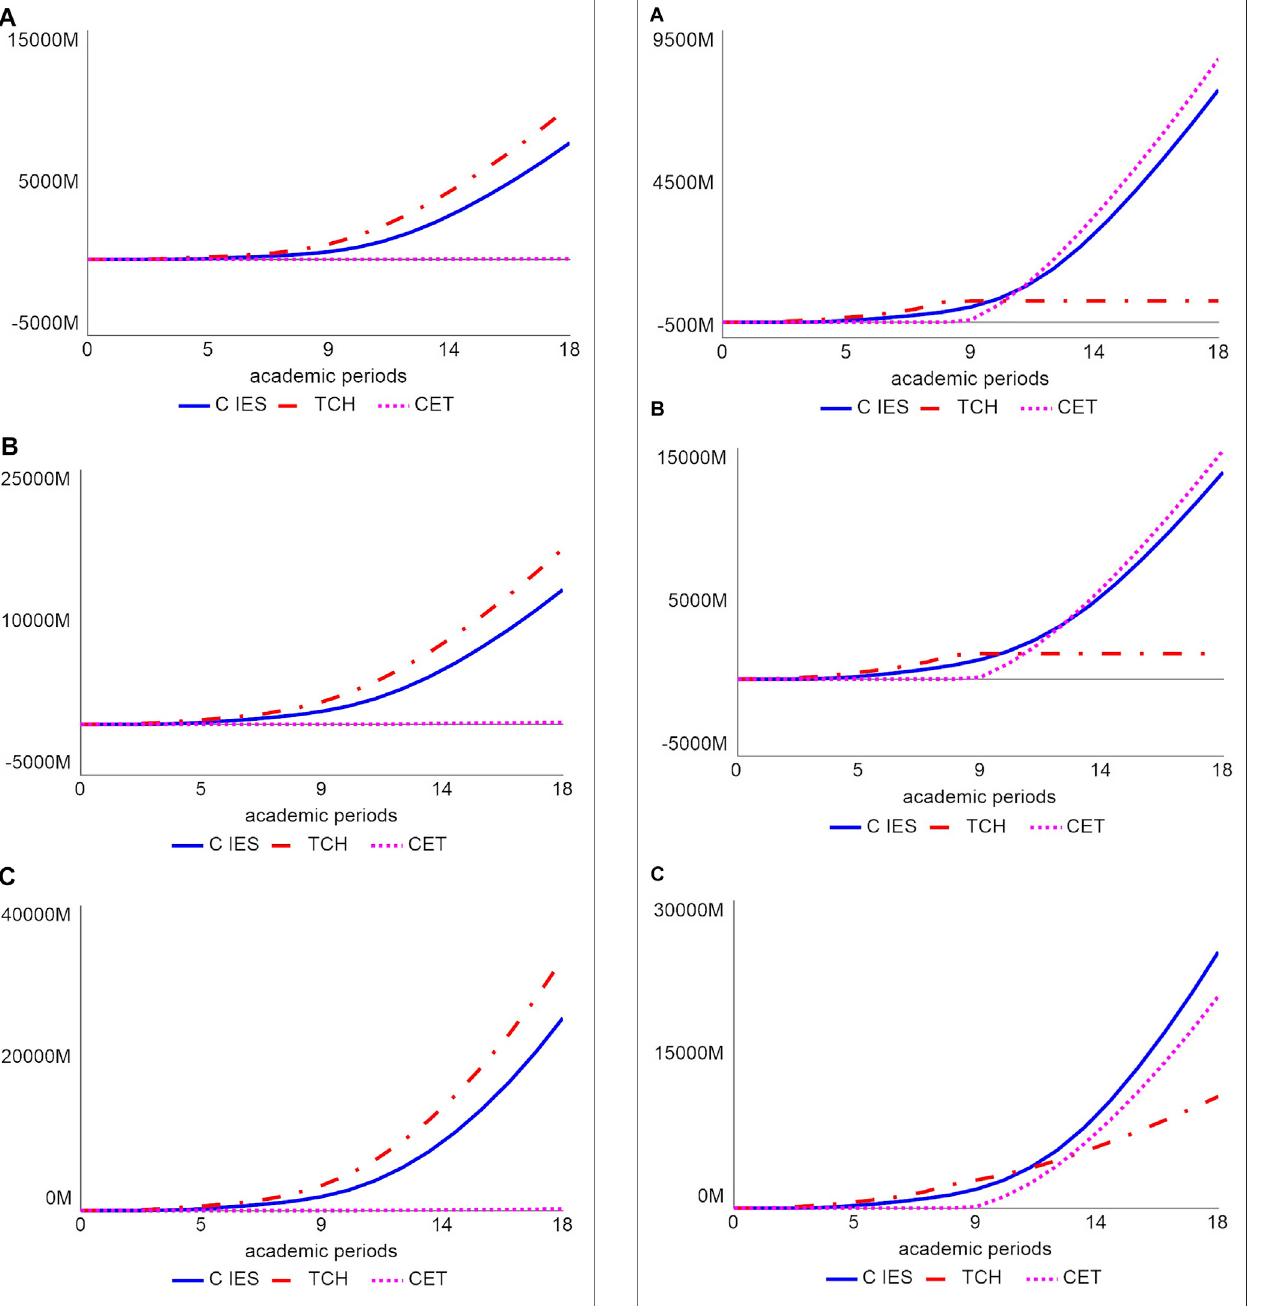
FIGURE 6 | Behaviour of the economic effects of drop-out for SIM-2. Note: (A) presents technical training programmes, (B) technological training and (C) professional training. C IES: Total cost for the training programmes under study per t . THC: Stranded cost for the family per t . CET: Total cost for the State per t .